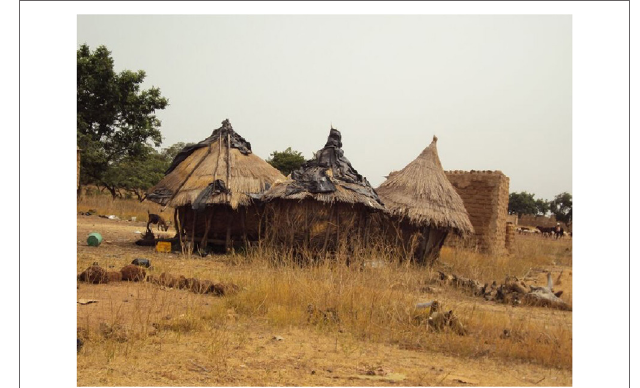
FiGURe 1 | Granaries in Burkina Faso, 2012 (courtesy of Ilaria Proietti, NOODLES